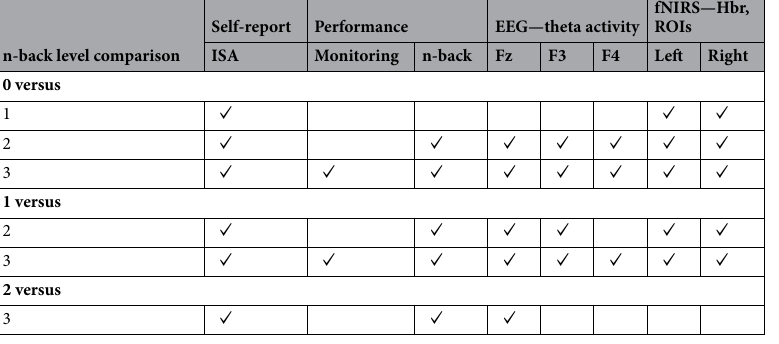
Table 1. Overview of different MWL measures and their ability to discriminate the four n-back levels. Significant differences ( p < 0.05) marked with ✓ . EEG alpha and beta activity are omitted as no significant comparisons were found.